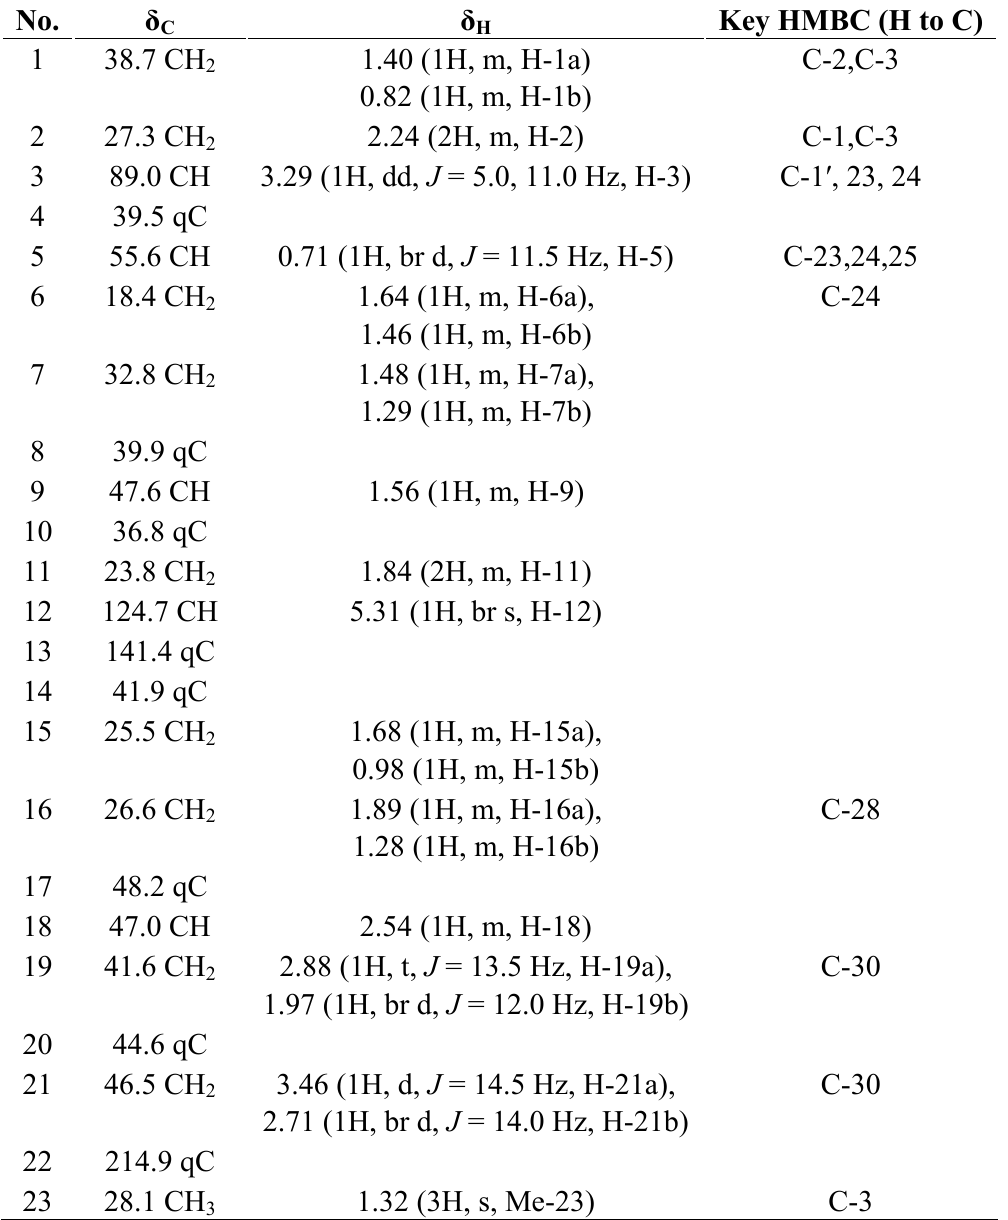
, δ in ppm, J in 5